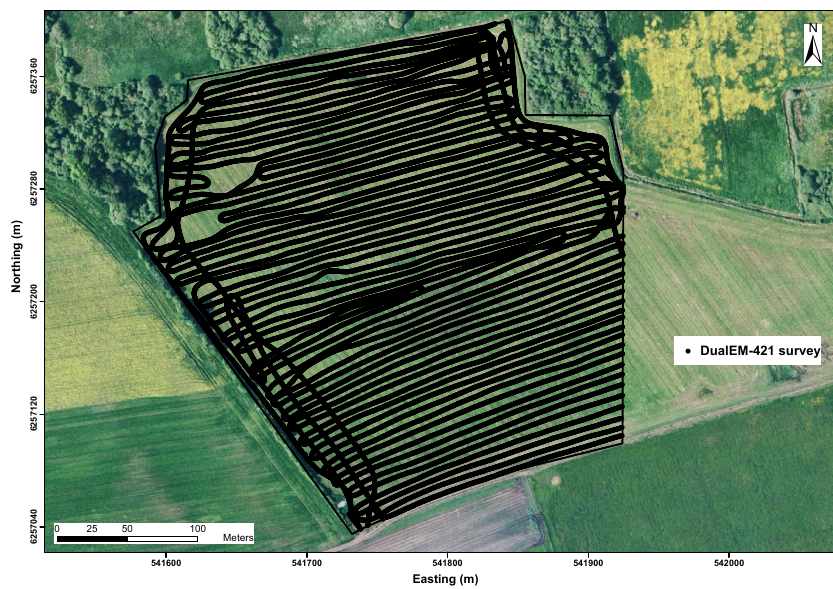
Figure 2. Location of the DUALEM-421S survey transects within the study